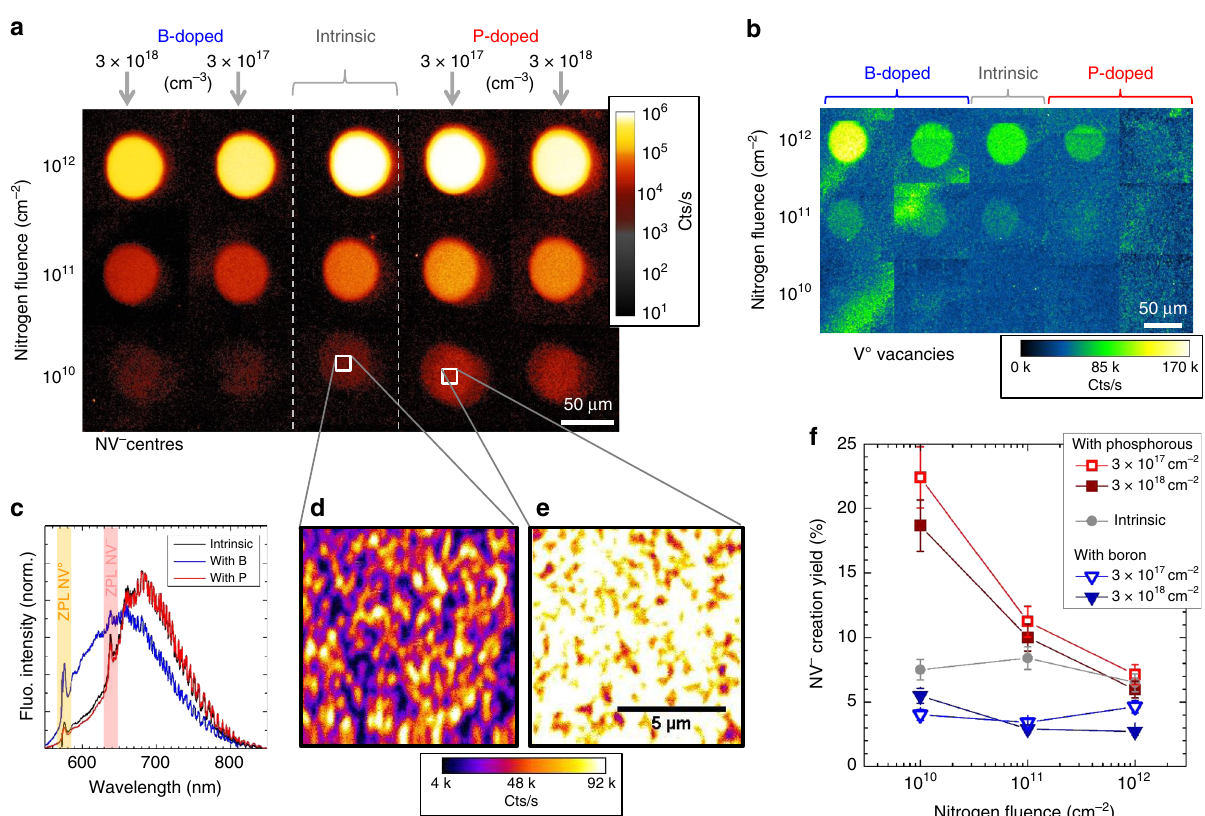
Fig. 3 Doping-dependent NV centre formation at 800 °C. a Confocal fl uorescence scans of the nitrogen implantations in the different doping areas recorded after thermal annealing at 800 °C for 4 h. The laser excitation is 532 nm and a longpass fi lter 600 nm is used to record the NV centres fl uorescence. The fl uorescence intensity is in logarithmic scale. b Confocal fl uorescence scans of the same areas measured directly after nitrogen implantation and before annealing. A longpass fi lter 700 nm is used to record V 0 (GR1) fl uorescence. c Normalised fl uorescence spectra of the NV centres fl uorescence (10 12 cm − 2 fl uence) showing the effect of the boron and the phosphorous doping with respect to the intrinsic region, respectively. The ZPL of NV 0 (575 nm) and of NV − (638 nm) are highlighted. Contrarily to boron (giving more NV 0 ), the effect of phosphorous on the NV charge state is minimal because for a 7.5% yield there are already ~ 13 unconverted N donors for each NV centre. d and e are closer scans (with linear fl uorescence scale) of two regions of interest of low nitrogen fl uence (10 10 cm − 2 ) for the intrinsic and phosphorous-doped diamond ([P] ~ 3 × 10 17 cm − 3 ). f NV centres creation yield vs nitrogen fl uence and doping type/level, deduced from a , d , and e . The Phosphorous doping induces up to a threefold yield improvement from 7.5% to 22.4%. The error bars represent the measurement uncertainties derived from the yield formula given in supplementary Equation